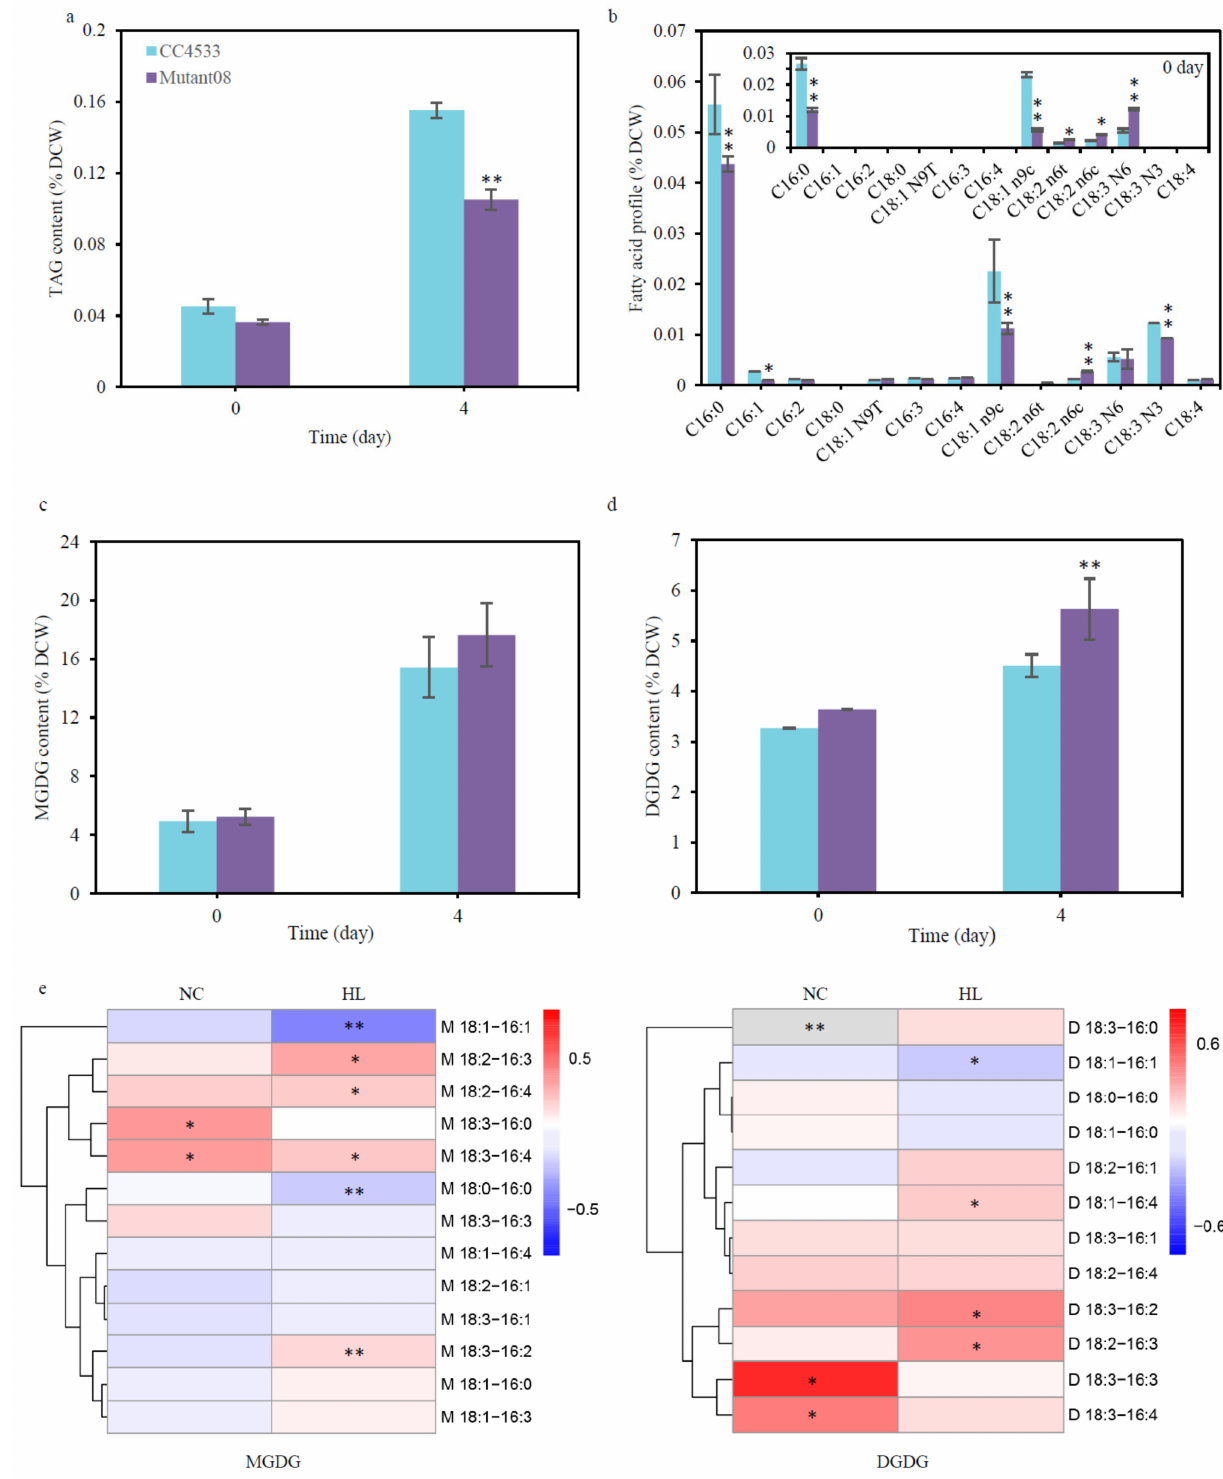
Figure 4. Insertional mutation of CrGH suppressed TAG accumulation and resulted in increases in the contents of galactolipids. ( a ). TAG contents of the wild type cc4533 and mutant08 grown under low light (LL) (day 0) and high light stress (HL) (day 4). ( b ). Fatty acid profile of the TAG. ( c ). Monogalactosyldiacylglycerol content. ( d ). Digalactosyldiacylglycerol content of the wild type cc4533 and mutant08 grown under LL (day 0) and HL (day 4). ( e ). Heatmap of the fold-changes in the galactolipids content in mutant08 as compared with that of the wild type cc4533. Fold-changes were calculated as log 10 (C(Tx, M8)/C(Tx, wt)). C M8 and C wt represent the contents of galactolipids in mutant08 and wild type cc4533 strains, respectively. Tx is time point. Data are presented as average ± SD (n = 3). * p < 0.05, ** p <